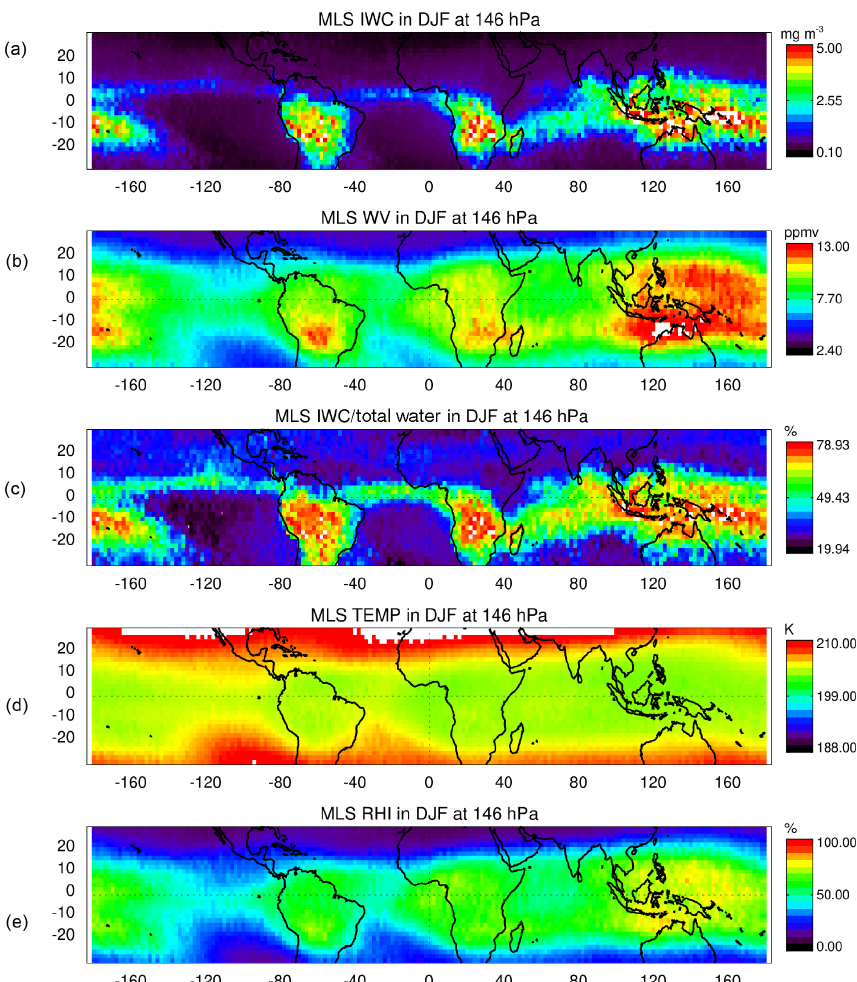
Figure 2. (a) Daily averaged ( ( day + night )/ 2) ice water content (IWC), (b) water vapour (WV), (c) IWC fraction (IWC / P W ), (d) temper- ature, and (e) relative humidity with respect to ice (RHI) in the upper troposphere (146hPa) measured by the MLS over the tropics in DJF over the period